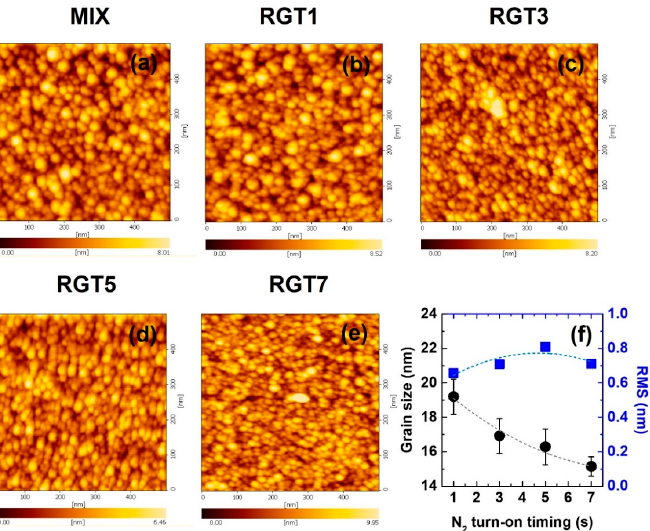
Figure 3. ( a – e ) AFM images of MIX, RGT1, RGT3, RGT5, and RGT7, respectively. ( f ) Relationship between the grain size and gas-timing N 2 turn-on time (black circles) and the roughness and gas- timing N 2 turn-on time (blue squares).